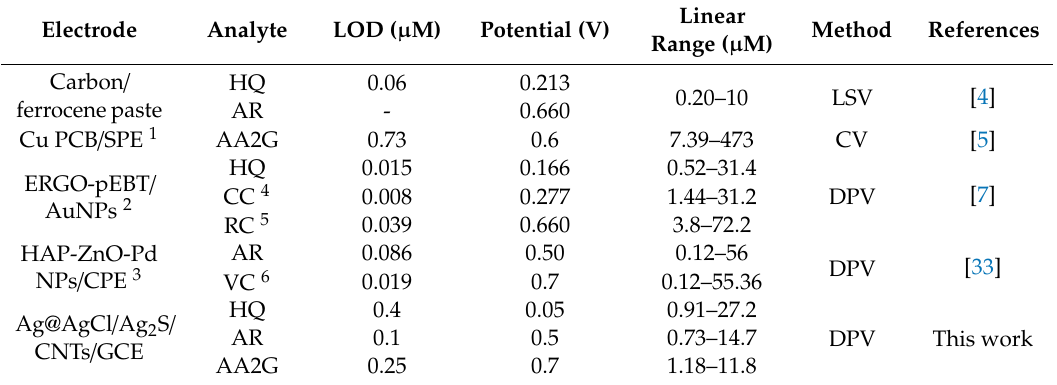
Table 1. Comparison of the performance of the proposed method with the previously reported